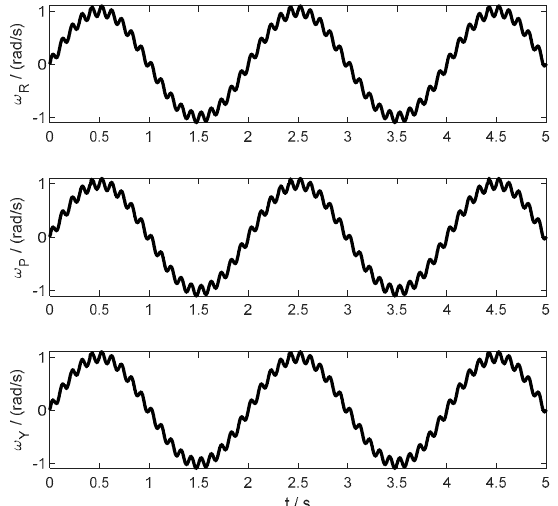
Figure 6. The angular velocity with external disturbance of the platform in the simulation of sine trajectory.